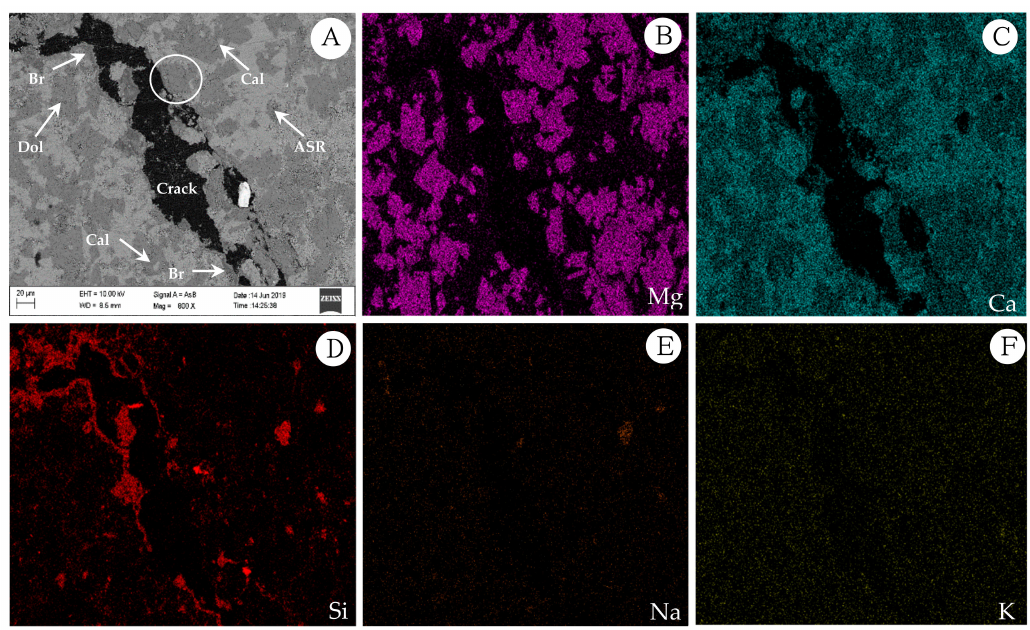
Figure 11. Element mapping of the RILEM AAR-5 concrete bars ( A – F ): Concrete microbars made with the dolomitic BFL1 aggregate in NaOH at 80 ◦ C after 196 days. ( A ) SEM photograph; ( B ) Mg in the spotted brucite and dolomite; ( C ) Ca in the spotted calcite and dolomite; ( D ) Si images; ( E ) Na images; ( F ) K images.